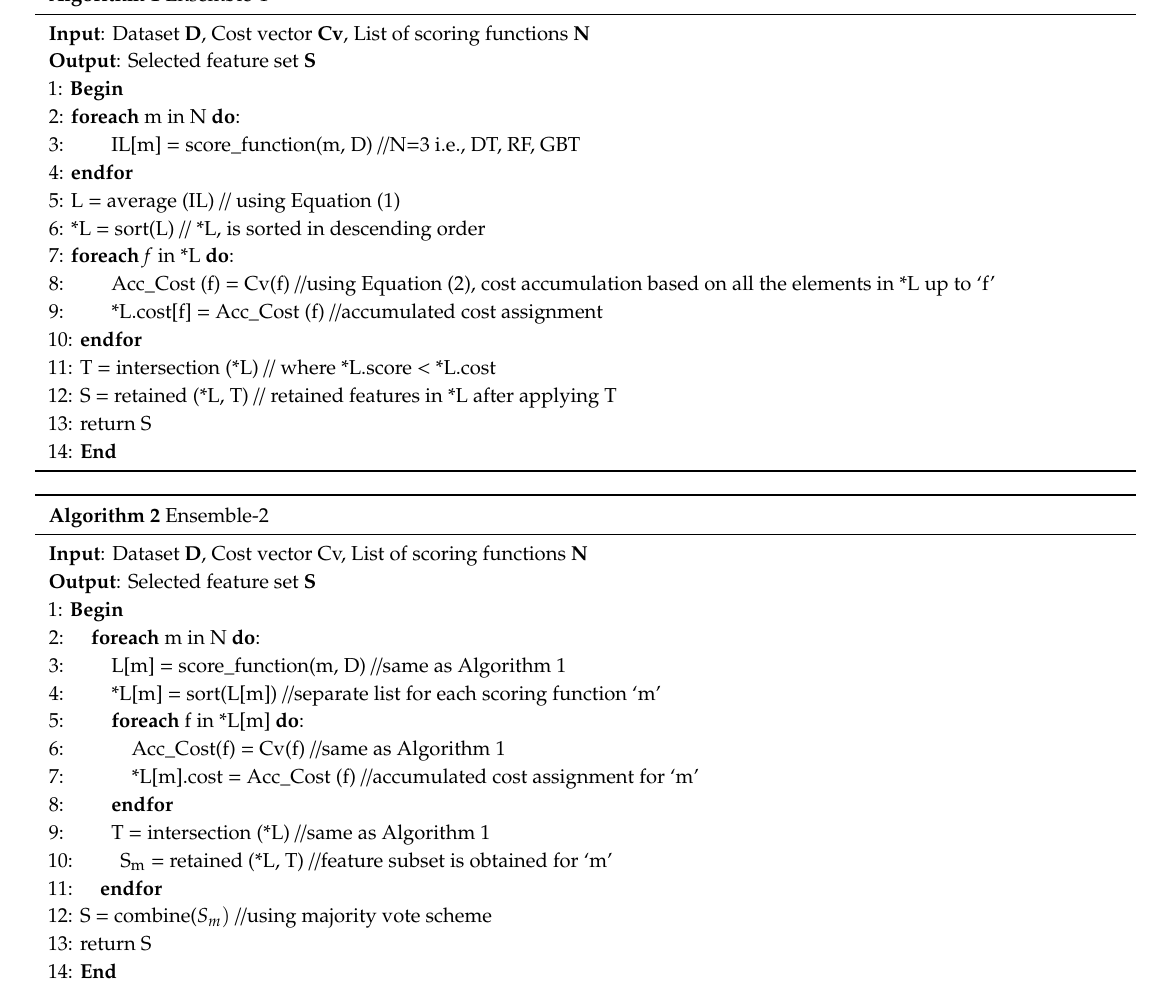
Algorithm 1 Ensemble-1